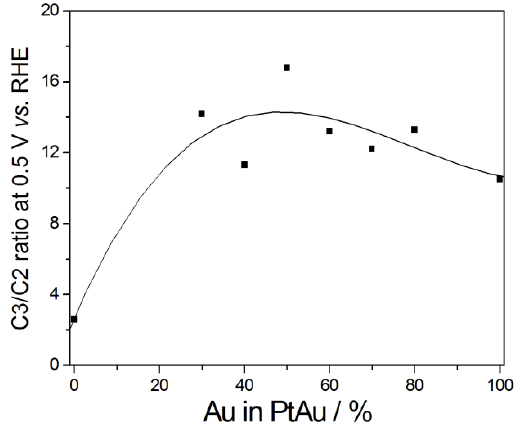
Figure 4. Dependence of the C3 / C2 ratio of GLY oxidation products at 0.5 V vs. RHE on Au content in PtAu catalysts from data in ref. [20].